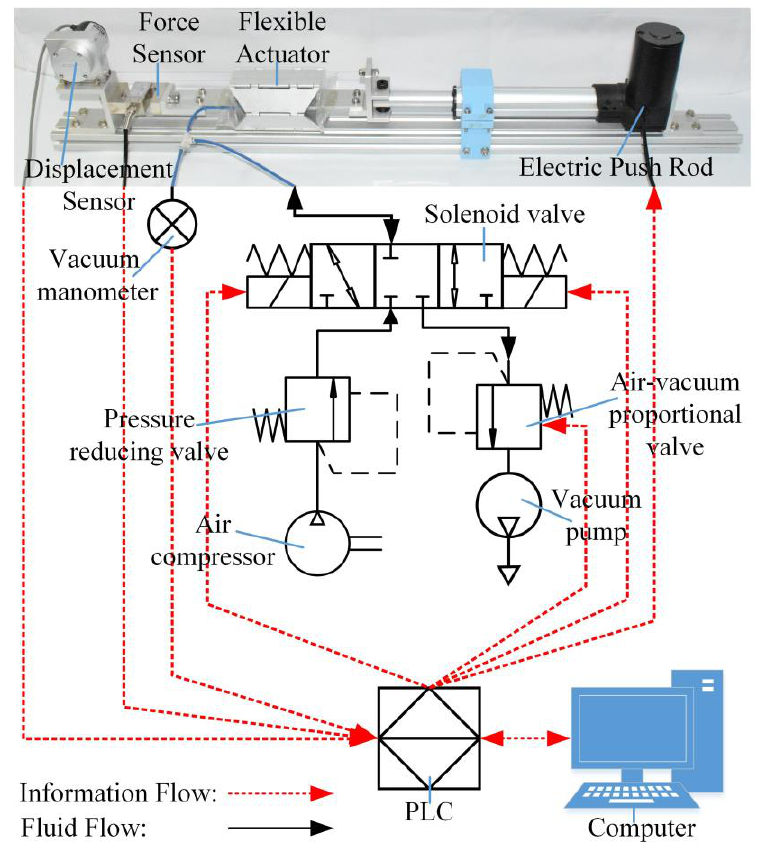
Figure 6. Test platform.